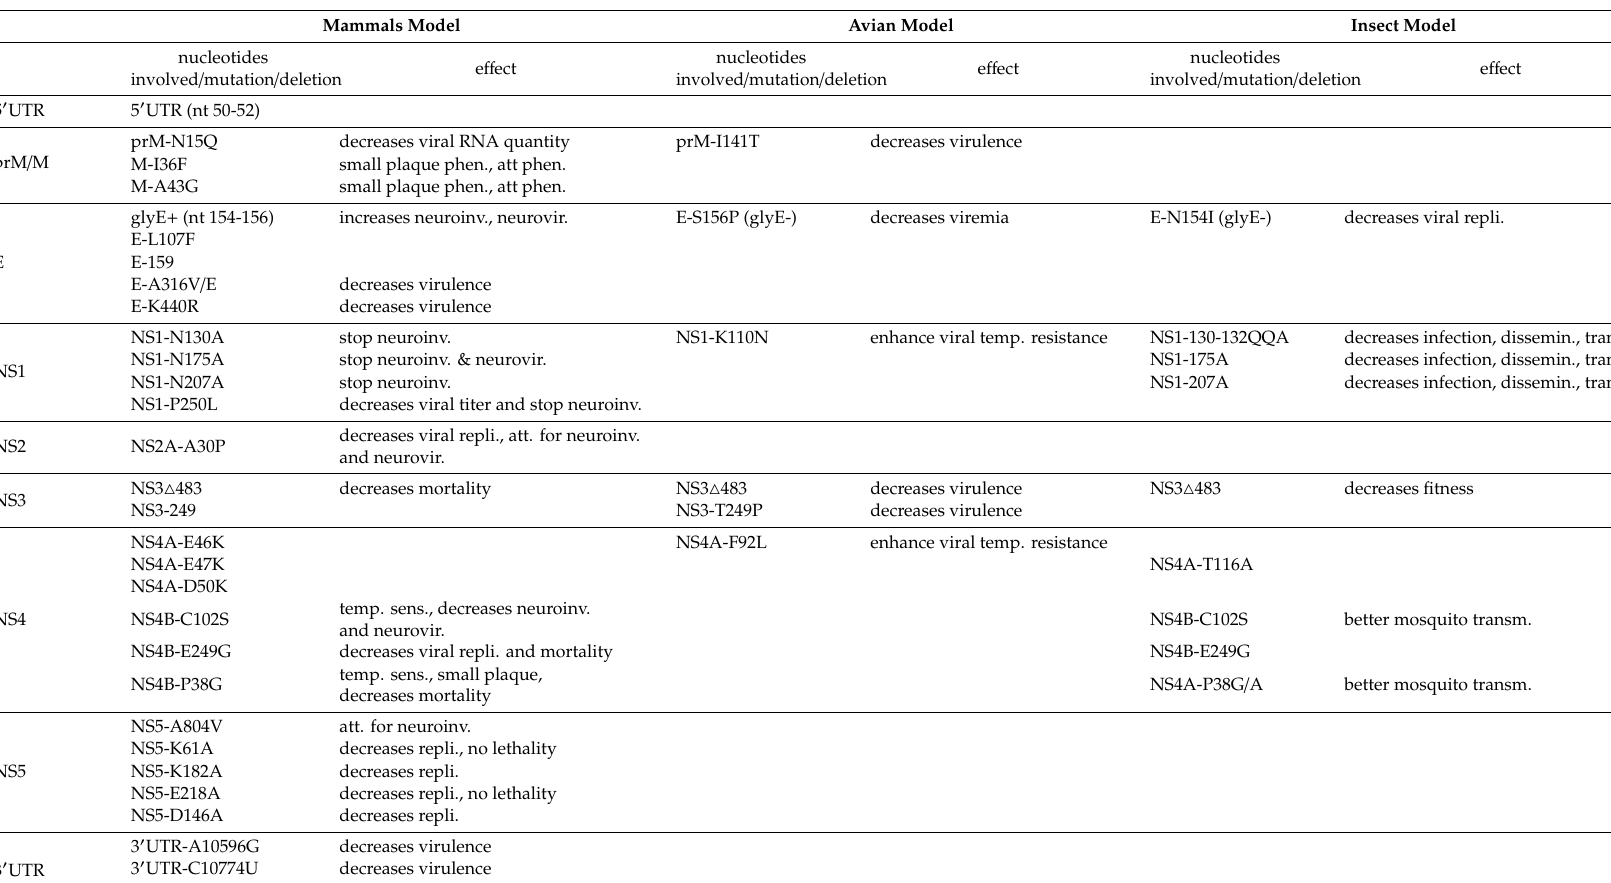
Table 1. Comparison of molecular virulence determinants of WNV in mammalian, avian, and insect models. The table details most of the residues involved in virulence variation in vivo and in vitro, as well as mutations or deletions most often observed. Green: mutations that decrease virulence. Red: mutation that increase virulence. Mammals Model Avian Model Insect Model nucleotides nucleotides nucleotides e ff ect e ff ect e ff involved / mutation / deletion involved / mutation / deletion involved / mutation / deletion